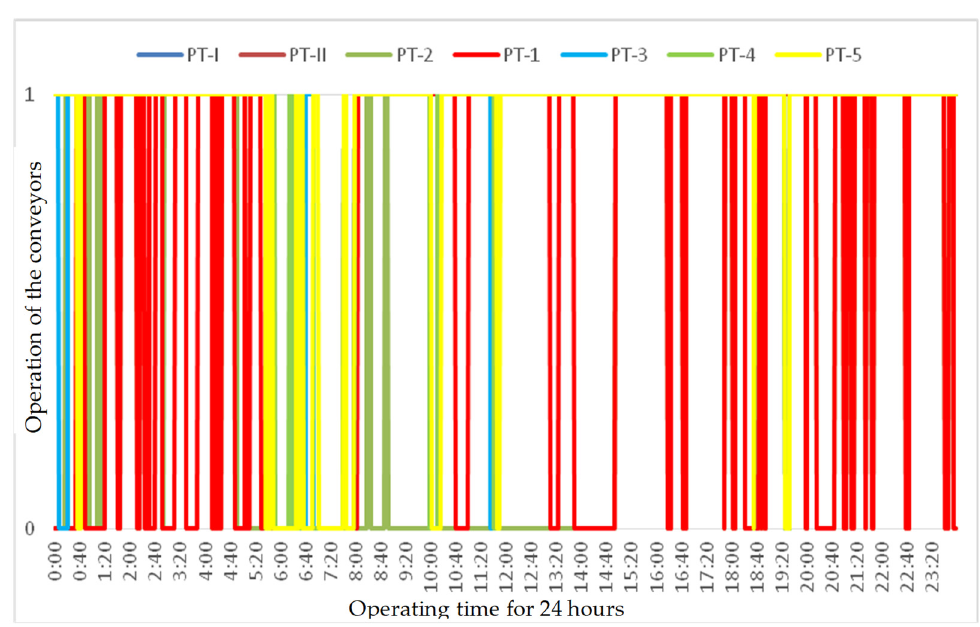
Figure 5. Graph for the operating time of the main haulage belt conveyors, where: 1—the operating time (it is in motion) of the conveyor belt, 0—the idle time (the machine is halted). Table 2. Measuring the running time of the main haulage belt